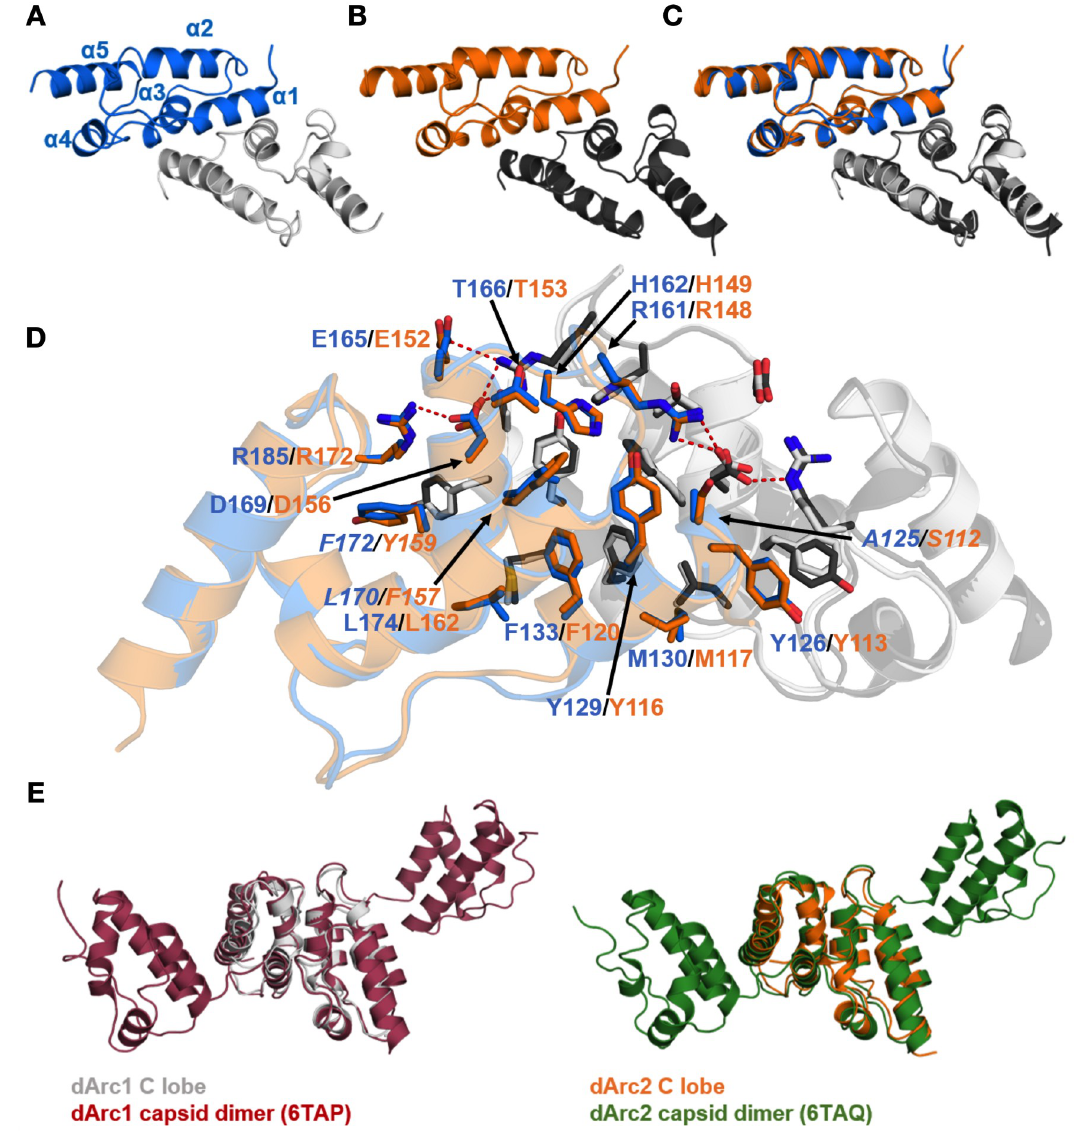
Fig 6. Crystal structures of the dArc1 and dArc2 C-lobes. (A) dArc1-CL. (B) dArc2-CL. (C) The two structures, which deviate with an all-atom RMSD of 0.48 Å , superimposed. (D) Residues contributing to the dimer interface in dArc-CL. dArc1-CL residues are marked in blue, and residues of dArc2-CL are marked in orange. Variable residues are indicated in italics. All residues contributing to the dimer interface are conserved, with the exception of A125 (dArc1) which corresponds to S112 (dArc2). Polar interactions are shown with red dashed lines. (D) A comparison of the dArc-CL crystal structures with the same domains in dArc capsids. Both the dArc1 and dArc2 C-lobes closely resemble their counterparts in the capsids, with an all-atom RMSD of 1.75 Å 2 and 1.13 Å 2 ,